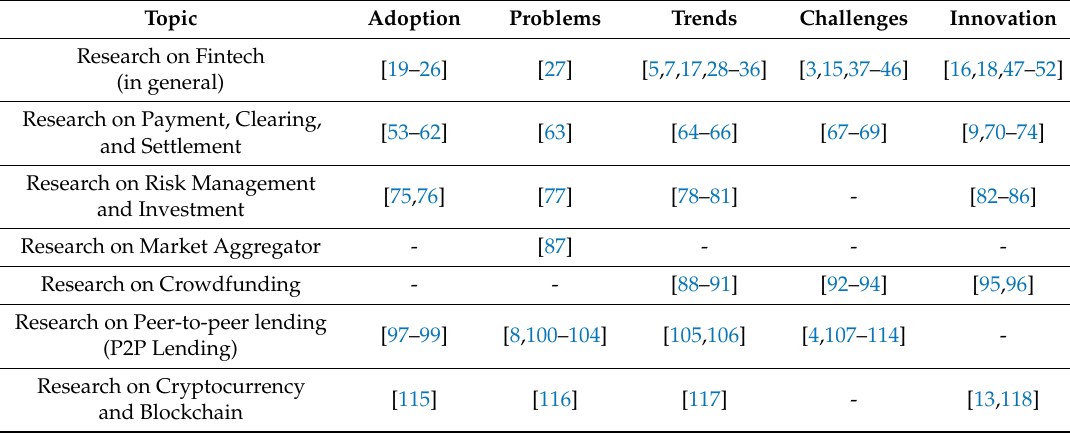
Table 2. Classification of articles by fintech business model.